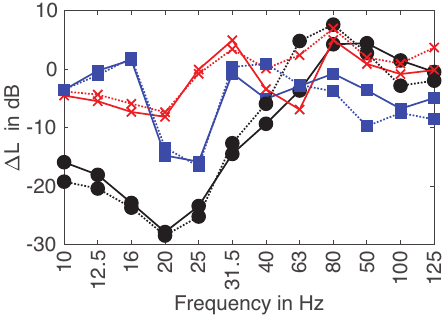
Figure 10. Level differences for recordings (dashed lines) and simulations (solid lines) for fl oor M4 (circles), fl oor M9 (crosses) and fl oor M10 (squares). Reference is fl oor M1. Figure 11. Driving point mobility calculated as 20log 10 (|